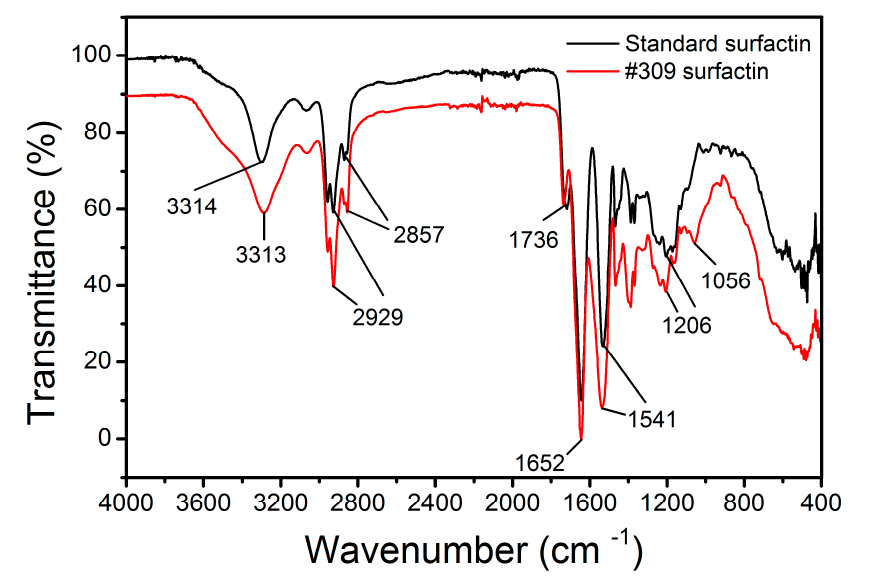
Figure 5. FTIR spectra of the surfactin produced by Bacillus subtilis #309 grown in mineral salt medium (MSM) supplemented with soap-derived crude glycerol and surfactin standard (Merck, Darmstadt, Germany).